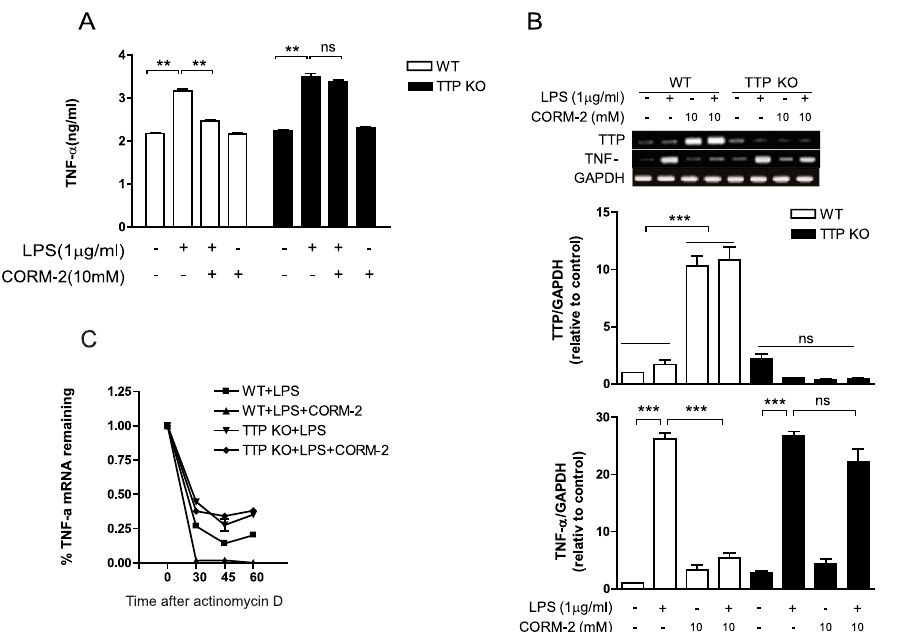
Figure 2. TTP deficiency blocks the anti-inflammatory function of CORM-2 in macrophages. Peritoneal macrophages were harvested from WT and TTP KO mice. Cells were treated with 1 m g/ml LPS in the presence of 10 m M CORM-2 for 4 h. A. TNF- a in the supernatant of cells was determined by ELISA. Data shown are mean 6 SD (n=3). **, p , 0.01. B. The expression levels of TTP and TNF- a mRNA were determined by semi- quantitative RT-PCR. C. Expression of TNF mRNA in macrophages was determined by quantitative real-time PCR at indicated times after the addition of 5 m g/ml actinomycin D. Values are mean 6 SD (n=3). ***, p , 0.001. The band densities in the agarose gel were quantified by PhosphorImager, normalized to the internal control GAPDH and expressed as percentage (%) of the value of untreated control cells. Data shown are mean 6 SD (n=3). ***, p , 0.005. ns, not significant.